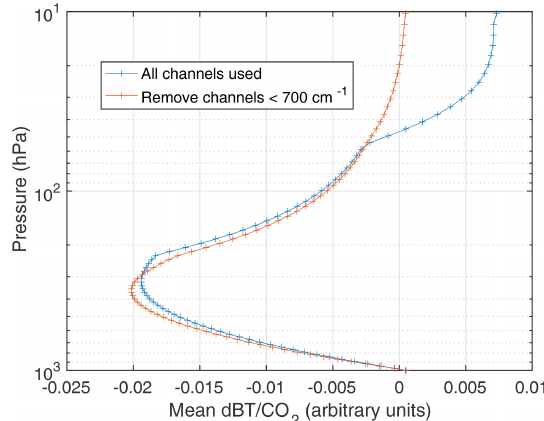
Figure 6. Mean of CO 2 Jacobians for all channels used in the anomaly retrievals, and the same if all channels below 700cm − 1 (stratospheric channels) are